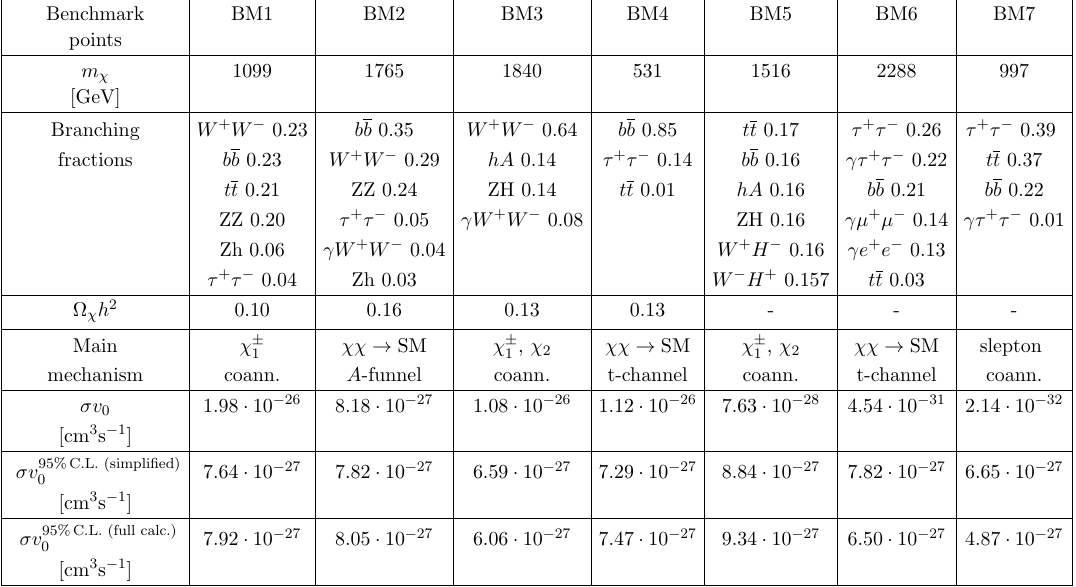
Table 3. Selected benchmark points characterized by di(cid:11)erent properties. The main annihilation mechanism at freeze-out corresponds to the (cid:12)nal state with the largest branching ratio. The theo- retical value of the cross section (cid:27)v 0 is given as well as the relic density (cid:10) (cid:31) h 2 . CTA sensitivity is reported for the simpli(cid:12)ed and full scheme computation. The sensitivity is expressed as 95% C.L. upper limits. The LLRTS value is derived according to eq. (2.2) for the given (cid:27)v 0 in the two computation